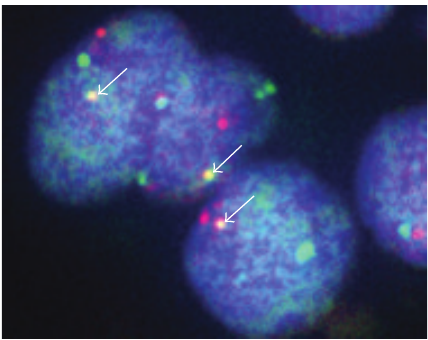
Figure 8: A dual-color FISH analysis showing the fusion gene as a single yellow (overlapping) signal (arrows), including a green ( NSD3 ) and an orange ( NUT )